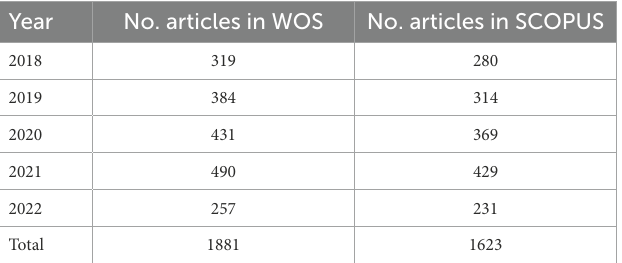
TABLE 1 Number of articles found with the search terms social responsibility and